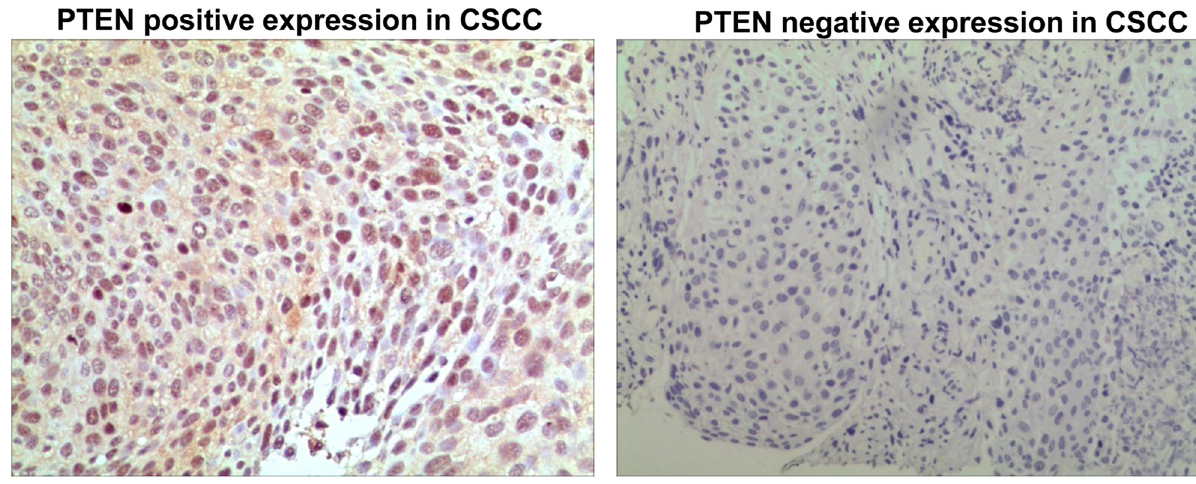
Figure 2: PTEN expression in CSCC. Magni fi cation: ×